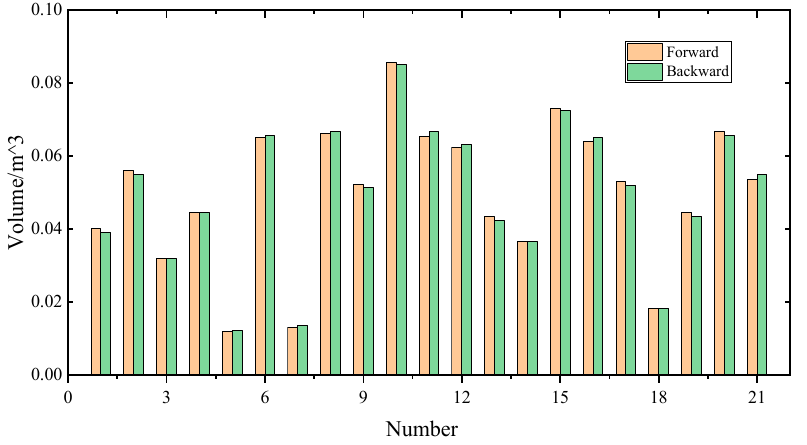
Figure 16. Comparison results of volume calculation from forward and backward measurements.